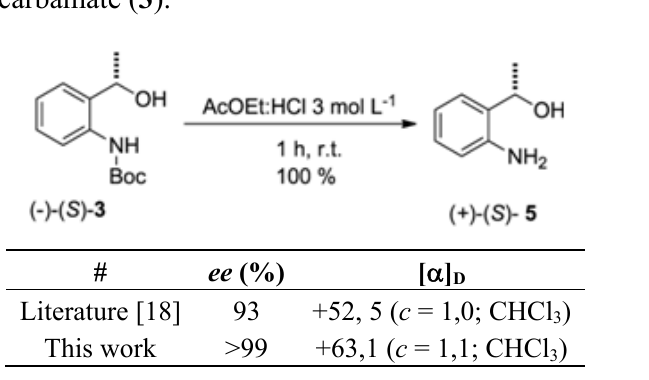
6. Assignment of the absolute configuration of tert -butyl 2-(1- hydroxyethyl)phenylcarbamate ( 3 ).